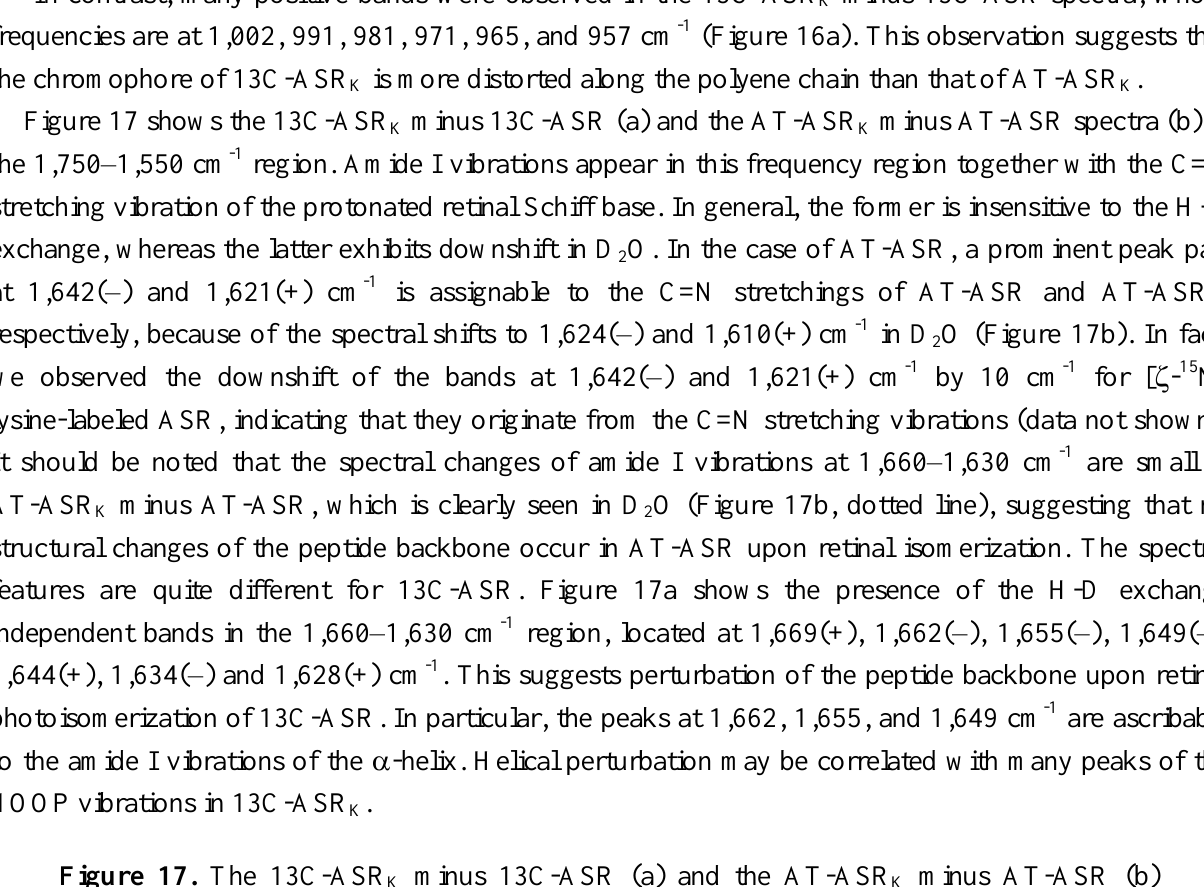
Figure 17. The 13C-ASR minus 13C-ASR (a) and the AT-ASR minus AT-ASR (b) K K spectra (pH 7) in the 1,750–1,550 cm -1 region, mostly representing vibrations of the protein moiety. The sample was hydrated with H O (solid lines) or D O (dotted lines). One division 2 2 of the y-axis corresponds to 0.0025 absorbance units. This figure is reprinted with permission from Kawanabe et al. [59]. Copyright 2006 American Chemical